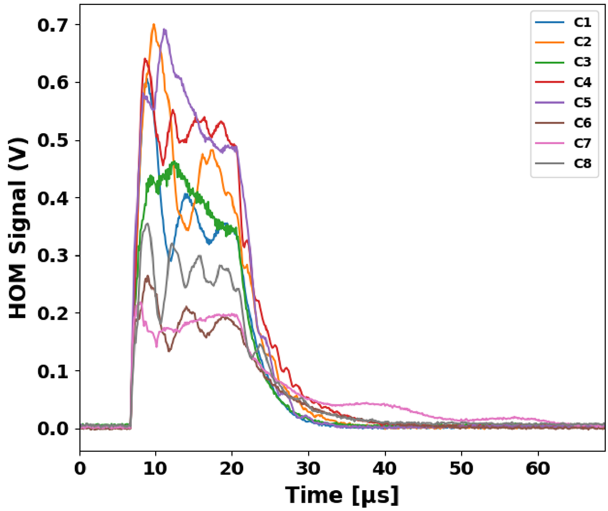
FIG. 5. Initial US HOM waveforms for cavities 1 – 8 as indicated with one wideband amplifier switched on. All eight Schottky detector signals are now measurable on the same shot. These are the dipolar modes using 50 b over a 16 . 6 μ s temporal extent. Growth of the signal after the first bunch is seen in the leading edge of the waveform. V 125 ¼ þ 1 . 0 A ( þ 2 mrad) from the reference.